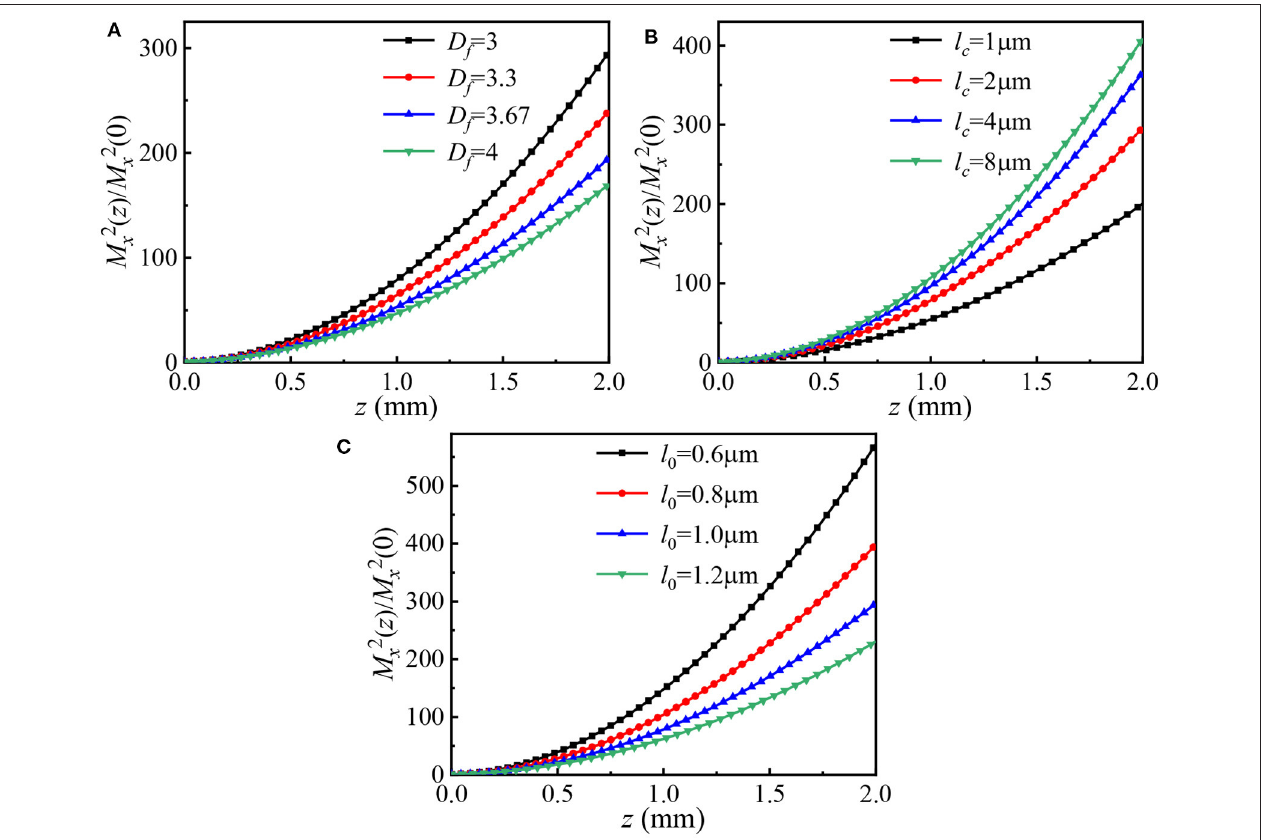
FIGURE 6 | Normalized propagation factors of HGCSM beams vs. propagation distance in turbulent biological tissue for different values of (A) the fractal dimension, (B) the characteristic length of heterogeneity, and (C) the small length-scale